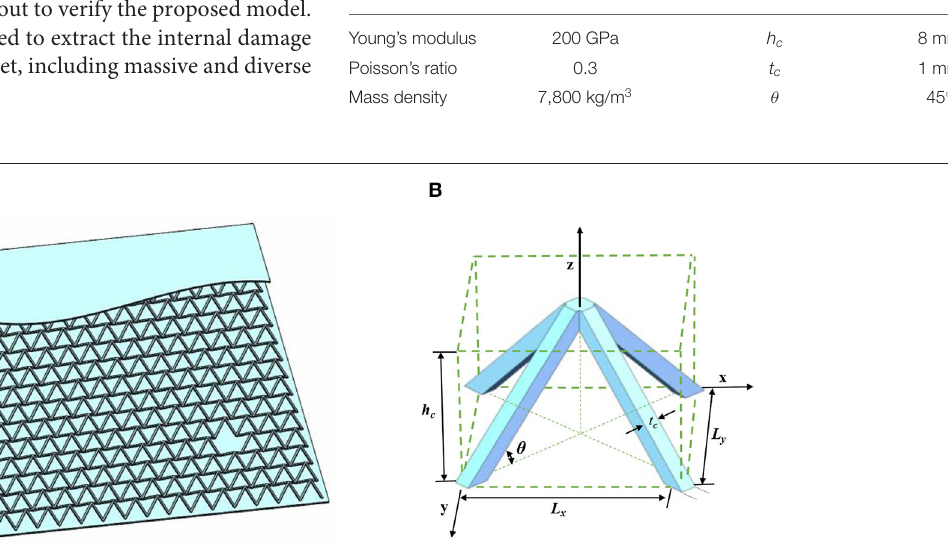
FIGURE 1 | Model information of sandwich panel with truss core (SPTC). (A) A damaged SPTC model. (B) A unit cell of a pyramidal truss.